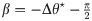
A light driven network of two coupled phase oscillators, representing the Per and Bmal-Rev loops, is able to reproduce experimental free-running and light perturbation data.A) Illustration of the phase oscillator concept. B) Schematic drawing of our conceptual model of light-driven, interlocked intra-cellular feedback loops. C) Isoclines of constant phase difference between the Per and the Bmal-Rev loops, color-coded for different values of β. Black lines denote the borders of synchronization between the Per and Bmal-Rev loops as determined by Eq (4) in Section Materials and Methods. Isoclines of constant Δθ⋆ = −0.7π, corresponding to the experimentally observed phase difference of approximately 9 h between Per1 and Bmal1 expression in the time domain, are plotted and color-coded for different values of β, ranging from β=−Δθ⋆−π2 to β=−Δθ⋆+π2 in 20 equidistant steps. The experimentally observed oscillation period τ⋆ ≈ 24.53h and phase difference has been estimated by cosine fits to Per1 and Bmal1 circadian gene expressions from high-throughput transcriptome data of 48h length at 2h sampling intervals [33], see S3 Fig. General distributions of phase differences Δθ⋆ within the range of synchronization between Per and Bmal-Rev loops for different values of β are depicted in S4 Fig D) Dynamics of experimentally observed Per1 and Bmal1 gene expression rhythms can be reproduced by the concpetual oscillator model. Bold lines denote the cosine of oscillation phases θP(t) and θR(t) of the corresponding Per and Bmal-Rev loop. E) Weakly coupled Per and Bmal-Rev loops can account for a faster re-entrainment of Per1 compared to Bmal1 gene expression oscillations after a 6h phase advancing jet-lag.